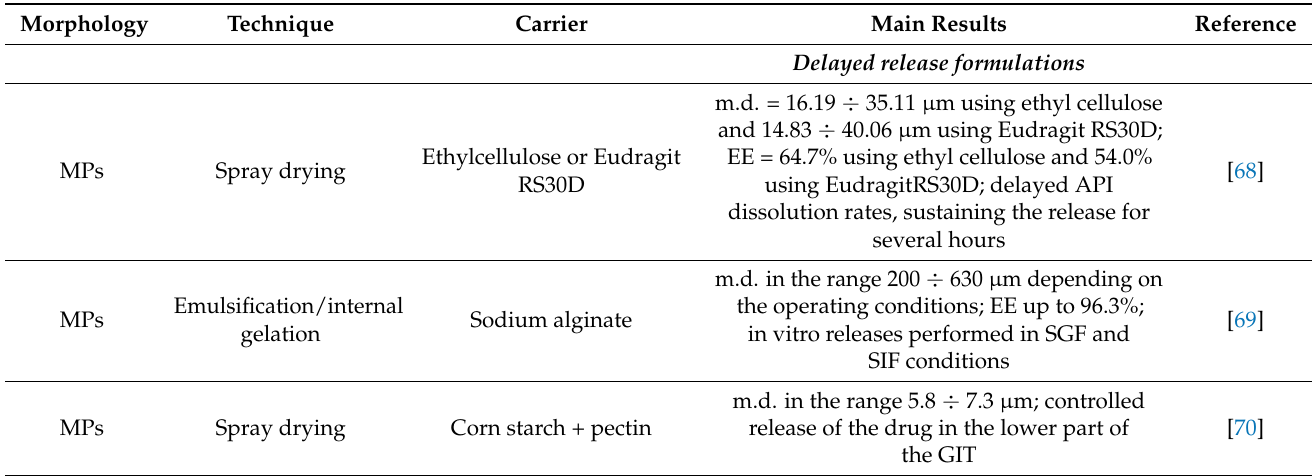
Table 3. Diclofenac sodium processing. BALB = mouse embryonic fibroblasts; Caco2 = human colon carcinoma cells; EE = encapsulation efficiency; GIT = gastro-intestinal tract; HP β Cd =